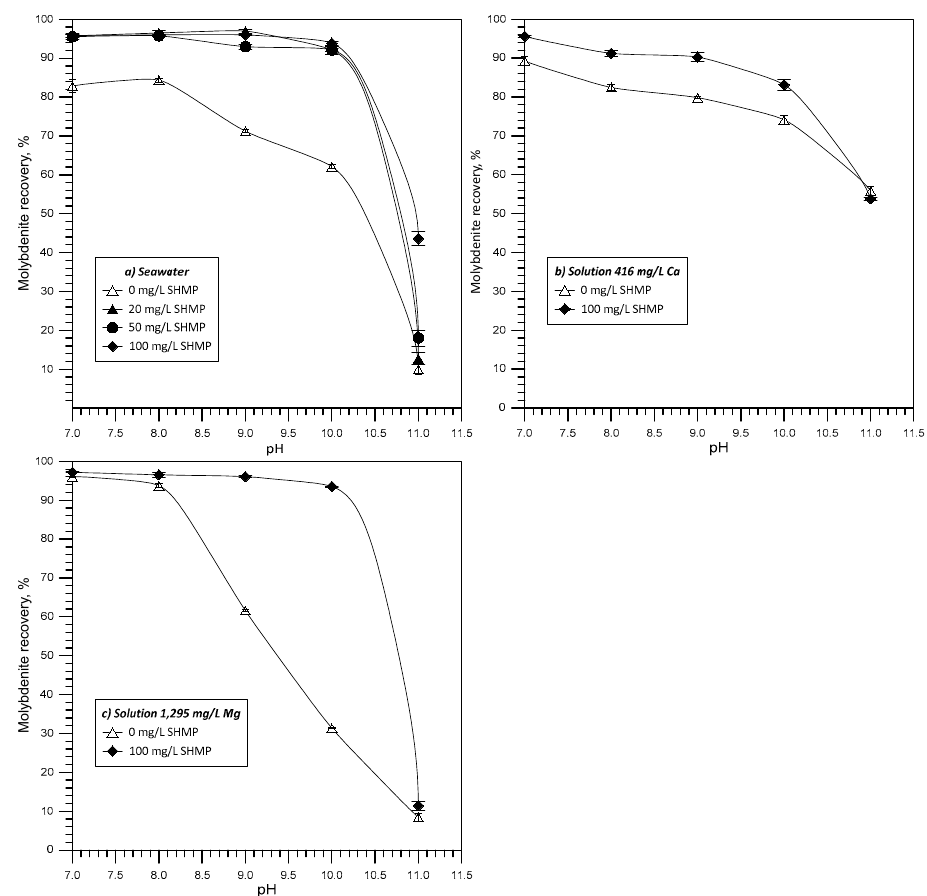
Figure 2. Recovery of molybdenite in the presence of 15% kaolinite, with and without sodium hexametaphosphate (SHMP), and in different aqueous solutions, i.e., ( a ) seawater, ( b ) 416 mg/L Ca, and ( c ) 1,295 mg/L Mg.